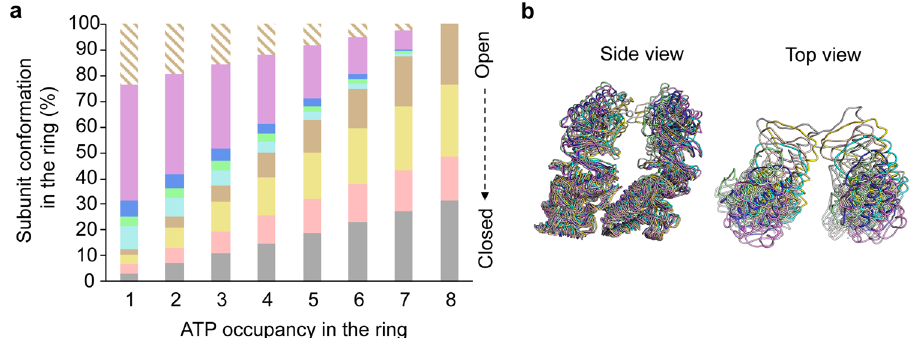
Fig. 6 Intra-ring subunit conformational heterogeneity. a The average intra-ring subunit conformation composition at different nucleotide occupancy levels. The colors are consistent with subunit maps and models of each conformation used in Fig. 2. For example, the gray color represents the most closed conformation (class 8) and the pink color represents the most open conformation (class 1) as shown in Fig. 2. The diagonal stripes represent the classes not analyzed because of poor map resolvability. b Side view and top view of intra-ring neighboring subunits in eight conformations. Model colors are consistent with the colors of histograms in